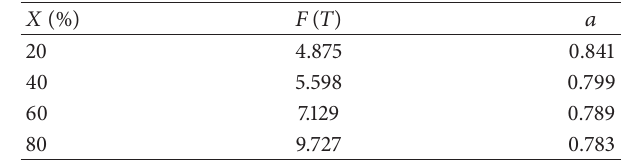
Table 2: Characteristic data of non-isothermal melt crystallization exotherms for MAG organogels.